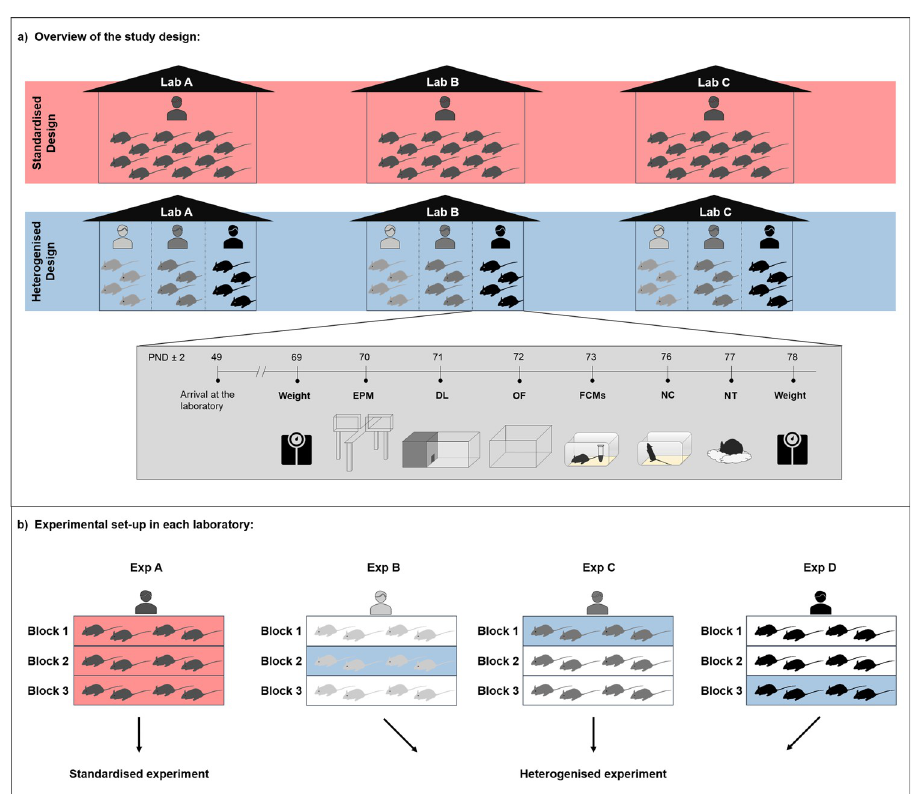
Fig 1. (a) Overview of the study design. To examine reproducibility of research findings across laboratories, the same animal experiment was independently repeated in 3 laboratories in both a conventionally standardised (red) and a heterogenised design (blue). In the standardised design, mice of 2 strains, C57BL/6J and DBA/2N ( n = 12 per strain), were tested by one experimenter, while in the heterogenised design, 3 different experimenters were involved in conducting the experiment (i.e., 4 mice per strain and experimenter were included in the analysis). Each experimenter, regardless of the design, conducted the same animal experiment following the same standardised protocols. All test procedures were conducted in the same order for all animals. ( b) Experimental setup in each laboratory. In each laboratory, 4 experimenters conducted the same animal experiment as described above. All 4 experiments were conducted according to a randomised block design including 3 blocks per experiment (Block 1–3). In each block, mice were housed in the same row in the same rack (e.g., top, middle, bottom) and, thus, these animals shared the same environmental background with respect to lighting conditions, humidity, and temperature. Out of these 4 experiments per laboratory, one was randomly selected and classified as standardised experiment (e.g., Exp A, red). For the heterogenised design, one block (i.e., 4 mice per strain) from each of the remaining 3 experimenters (Exp B–Exp D) was pseudo-randomly selected and classified as part of a heterogenised experiment. This was done in a way that in each heterogenised experiment all 3 blocks were represented. Please note: Shown is one example of a possible allocation of experimenters and blocks to the standardised and heterogenised design, respectively (for details, see “Data analysis” and S3 Table). Furthermore, only mice of one strain (half of the mice tested) are visualised in the figure. DL, Dark Light; EPM, Elevated Plus Maze; FCMs, faecal corticosterone metabolites; NC, Novel Cage; NT, Nest; OF, Open Field; PND, postnatal